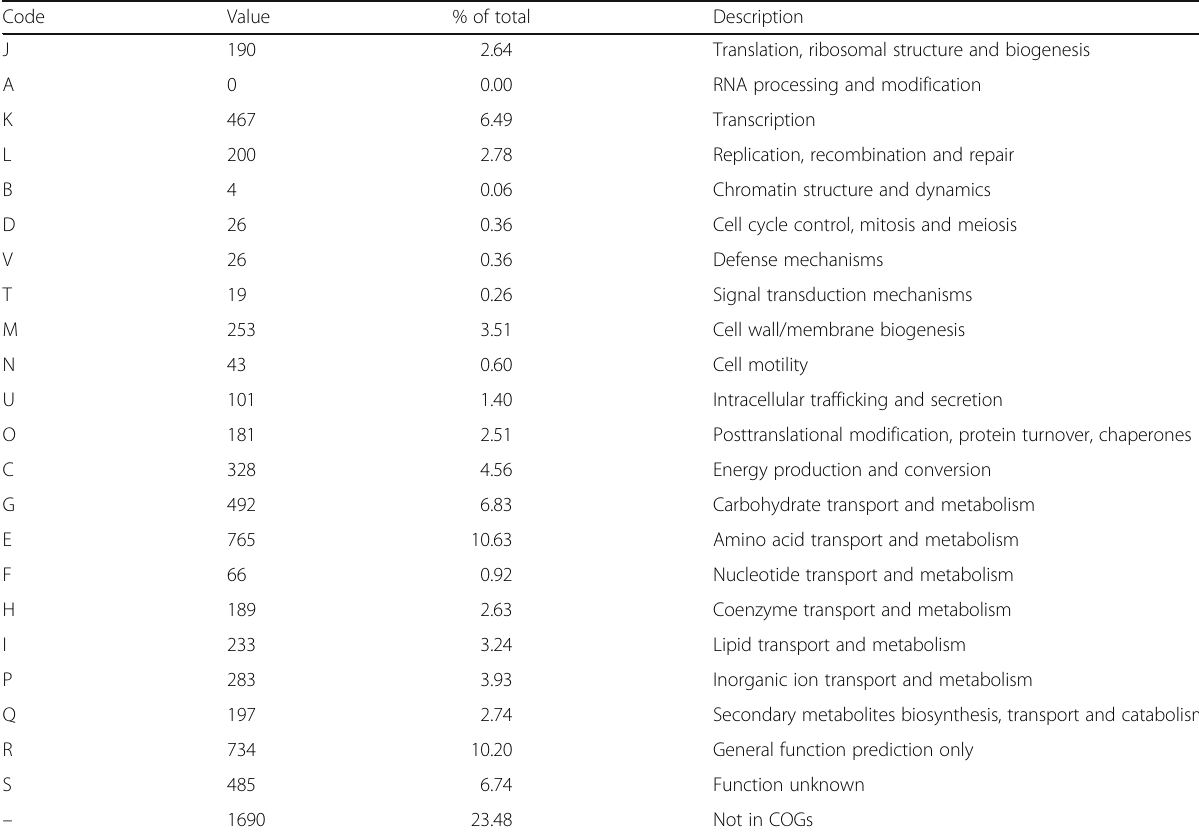
Table 4 Number of genes associated with the general COG functional categories Code